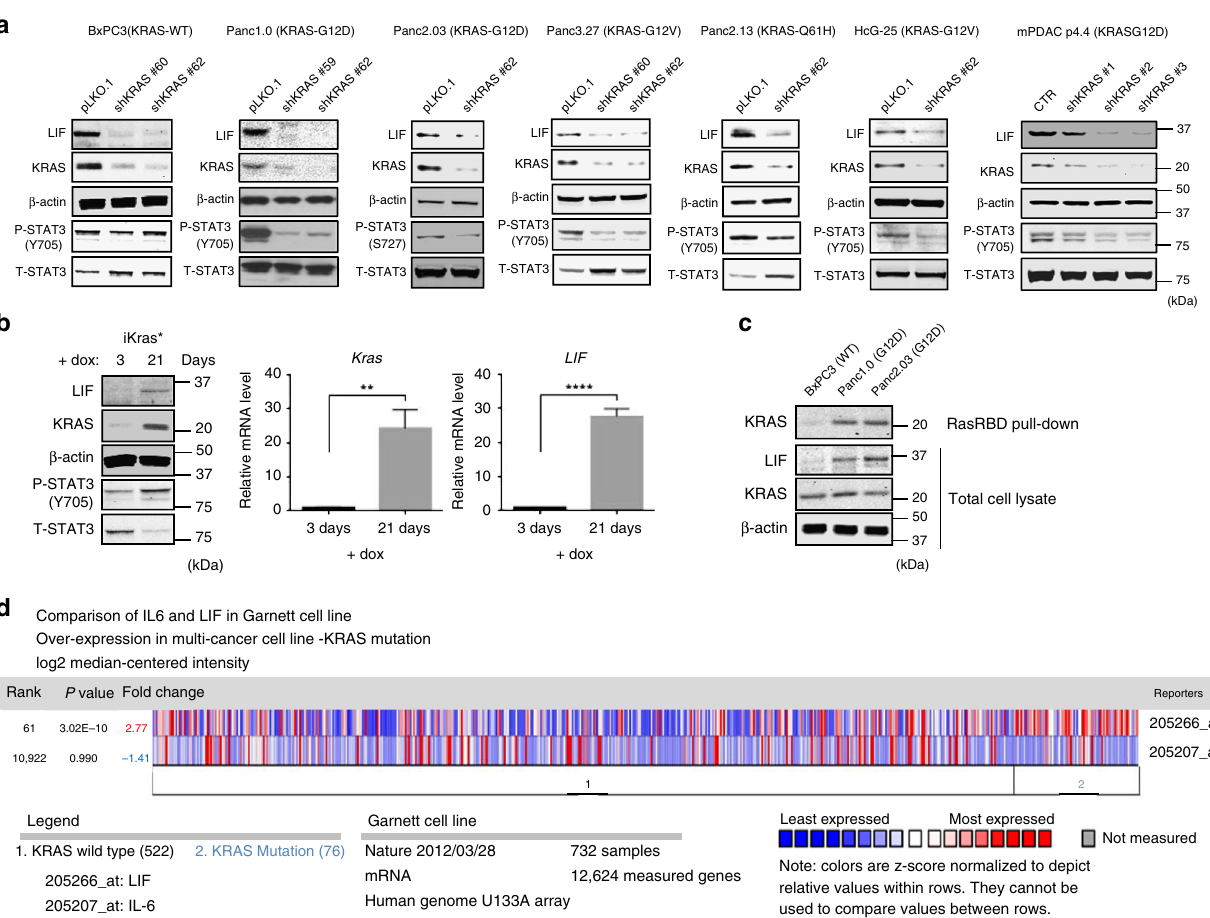
Legend Garnett cell line Nature 2012/03/28 1. KRAS wild type (522) 2. KRAS Mutation (76) Note: colors are z-score normalized to depict 12,624 measured genesmRNA relative values within rows. They cannot be Human genome U133A array used to compare values between rows. Fig. 1 Oncogenic KRAS regulates the expression of LIF, but not other IL-6 family cytokines. a Representative western blots showing the amounts of LIF, KRAS, and phosphorylated STAT3 at Y-705 in multiple human and mouse pancreatic cancer cell lines where wild-type or mutant KRAS have been stably knocked down by shRNAs. b Representative western blots showing increased expression of LIF, KRAS, and phosphorylated STAT3 at Y-705 in mouse pancreatic adenocarcinoma cell line (iKRAS*). Representative qPCR showing increased mRNA expression of LIF and KRAS in the same cell line ( N = 3; ** P < 0.01; **** P < 0.0001). Error bar represents the standard deviation and P -value was generated by t -test. Its expression of KRAS was reactivated by adding 1 µ g/mL of doxycycline in growth medium. iKRAS* line was harvested and established from pancreatic tumor developed in a p48Cre; TetO- KrasG12D; Rosa26rtTa/ + ; p53R172H/ + mouse. c Western bot suggesting increased expression of LIF in KRAS mutant human pancreatic cancer cell lines, Panc1.0 and Panc2.03, which had higher RasGTP level when compared to KRAS wild-type cell line, BxPC3. RasRBD pull-down assay was used to determine RasGTP level. The cells were serum-starved for 24 h before harvested for RasRBD pull-down. d Oncomine analysis suggesting upregulation of human LIF, but not IL-6, in the human cancer cell lines where KRAS is mutant when compared with cells expressing wild-type KRAS.The analysis in the pan-cancer cell lines (KRAS WT vs mutant) ( Nature volume 483 , pages 570 – 575 (29 March 2012)) was performed by using Oncomine Platform Software (Invitrogen;